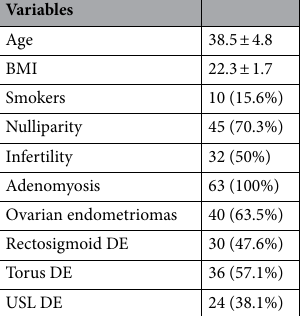
Table 1. Clinical characteristics of the enrolled population at baseline. Results are expressed as number and percentage or mean ± standard deviation. DE deep endometriosis, BMI body mass index, USL uterosacral